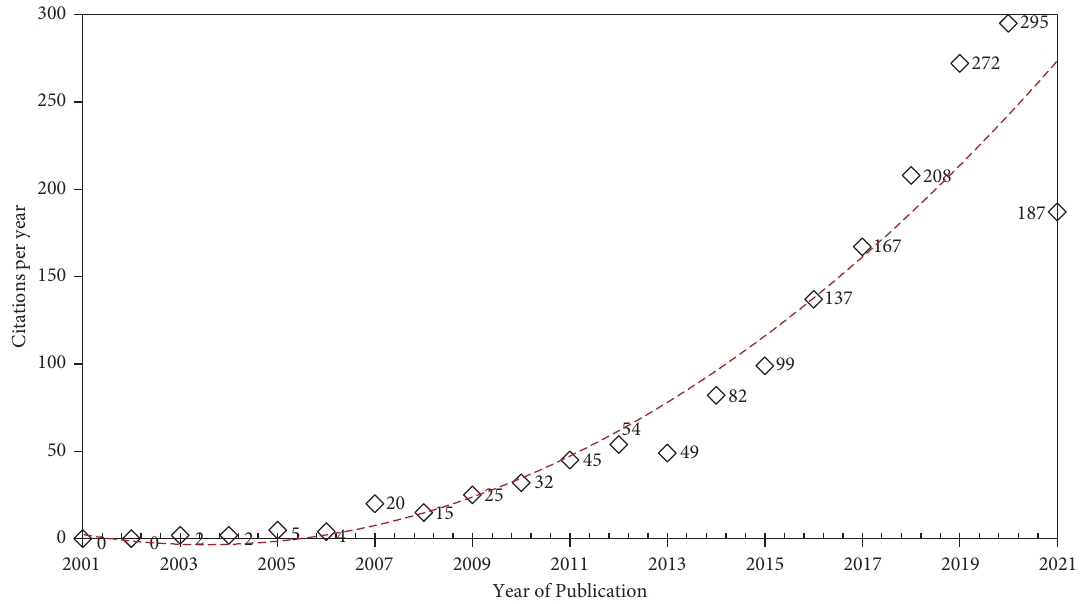
Figure 4: Publication history of [2] from Scopus database.